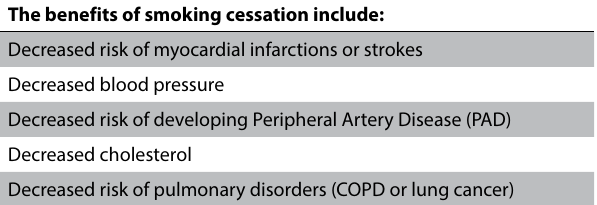
Table 2: Health Benefits of Smoking Cessation The benefits of smoking cessation